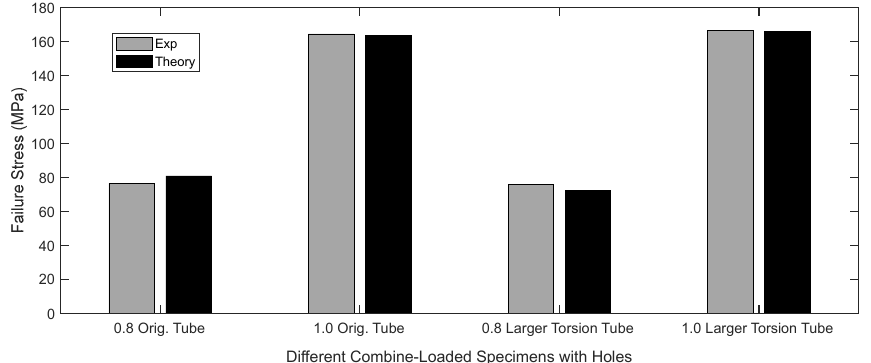
Figure 21. Comparison of the maximum stresses at the failure of combined loading specimens.